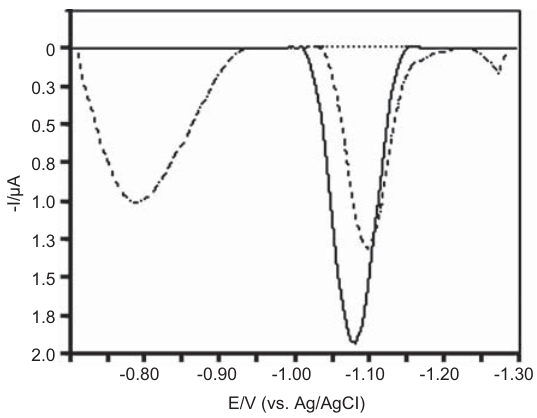
Figure 1 SW voltammograms of 40 µ m ABA in 0.10 m phos- phate buffer pH 3.0 (with 0.02 m NaCl) at PGE (dashed line) and at pencil-lead BiFE (solid line). SWV parameters: frequency, 25 Hz; scan increment, 8 mV; pulse amplitude, 20 mV. The blank solution is represented ( … ) at pencil-lead BiFE.